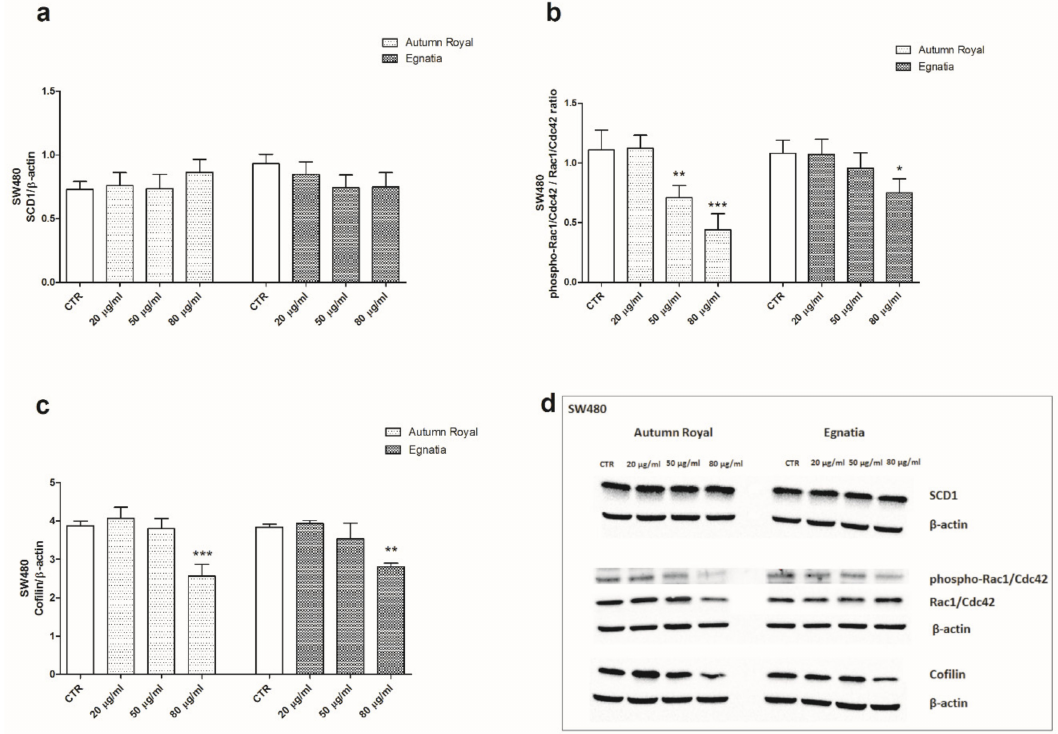
Figure 4. ( a ) SCD1 protein expression levels detected in SW480 cell line treated with increasing concentration of Autumn Royal and Egnatia GSEs (20, 50, and 80 µ g / mL), after 48 h of incubation; ( b ) Phospho-Rac1 / Cdc42 / Rac1 / Cdc42 ratio protein expression levels detected in SW480 cell line treated with increasing concentrations of Autumn Royal and Egnatia GSEs (20, 50, and 80 µ g / mL), after 48 h of incubation; ( c ) Cofilin protein expression levels detected in SW480 cell line treated with increasing concentrations of Autumn Royal and Egnatia GSEs (20, 50, and 80 µ g / mL), after 48 h of incubation. All data are expressed as mean ± Standard Deviation (SD) of three di ff erent experiments. p -value was determined by ANOVA with Dunnett’s post-test. * p < 0.05 and *** p < 0.01 versus the control group (CTR). ( d ) Representative blots evaluated in SW480 cells after Autumn Royal and